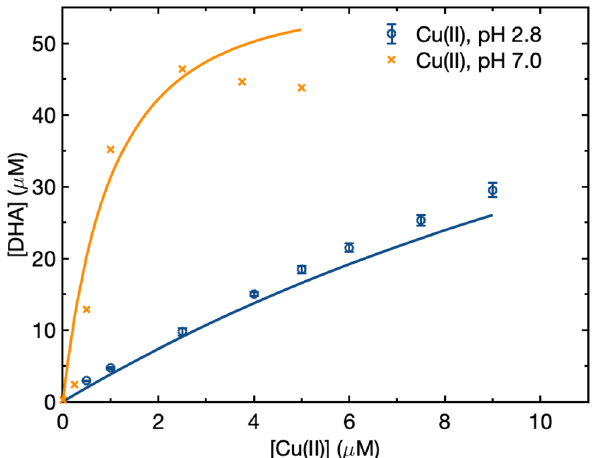
Figure 3. DHA formation from ascorbic acid in the presence of Cu(II). The circles and crosses represent experimental data for Cu(II) at pH 2.8 and Cu(II) at pH 7.0, respectively, and lines indicate corresponding model results based on the reactions shown in Tables 1 and 2. Error bars are shown for data with three measurements; measurements at pH 7 are only one repeat. The abscissa represents Cu(II) concentration in the first reaction coil and ordinate represents DHA formation in the second reaction